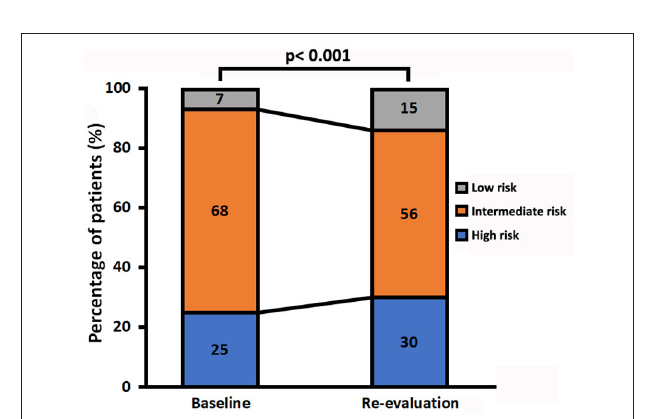
FIGURE 3 | Change in the three risk groups in patients with idiopathic pulmonary arterial hypertension from baseline to re-evaluation.